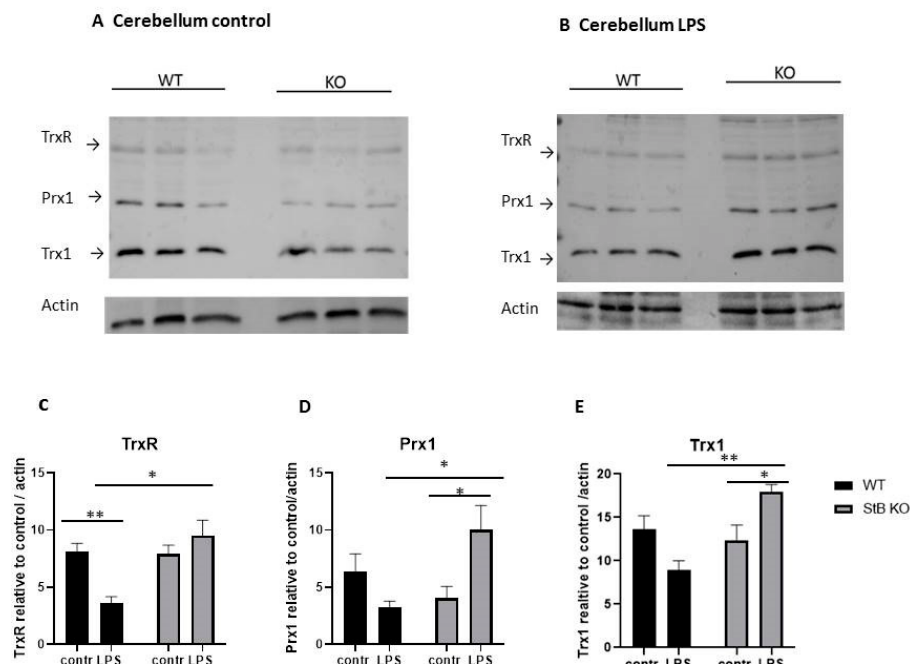
Figure 2. Thioredoxin reductase (TrxR), peroxiredoxin 1 (Prx1), and thioredoxin 1 (Trx1) protein levels in cerebella of stefin B-deficient (KO) and control (WT) mice after LPS challenge (n = 6). Age-matched control FVB/N mice (WT) and stefin B-deficient (KO) were left untreated or were injected with LPS (3 mg/kg body weight). 4 h after LPS challenge animals were sacrificed. Cerebellar tissue lysates of control mice ( A ) or LPS injected animals ( B ) were analyzed by Western blots with specific antibodies. Anti β -actin antibodies were used as loading controls. The levels of TrxR ( C ), Prx1 ( D ) and Trx1( E ) in cerebellar lysates from wild type (WT) and stefin B-deficient (KO) mice in comparison to β -actin controls were quantified by ImageJ. Statistically significant differences vs. control group, * p < 0.05, ** p ≤